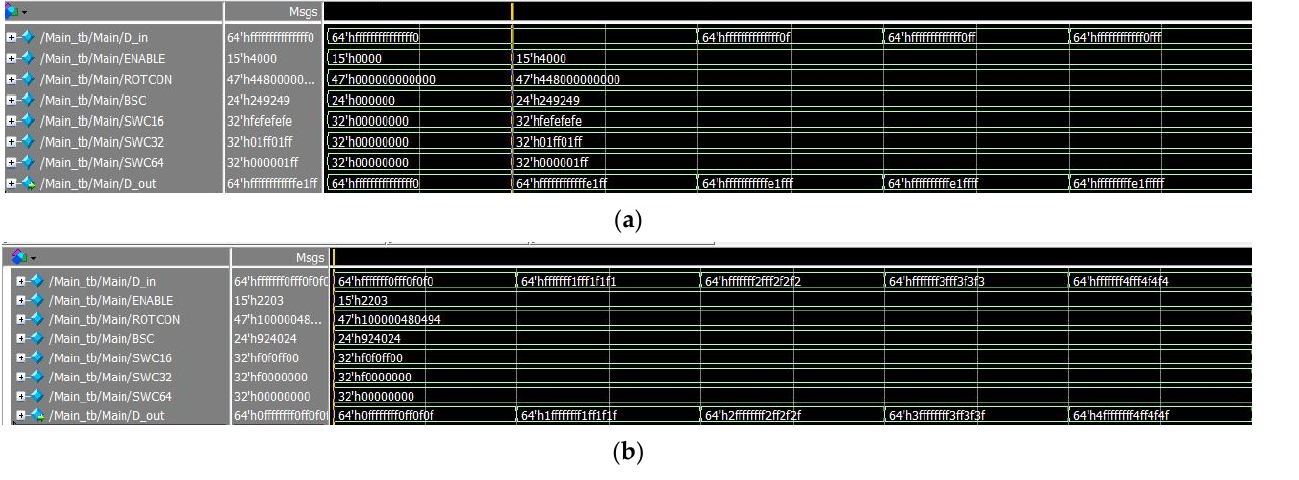
Figure 11. ( a ) The signal flow of RSTU executing a 9-bit left rotation operation for D_in. ( b ) The Signal flow of RSTU executing a 4-bit right rotation for the upper 32-bit of D_in, an 8-bit left rotation for D_in [31:16], and two 4-bit left rotation for the lower octet and next lower octet of D_in. For the second group excitation vectors, ENABLE and ROTCON have stated that RSTU implements a 4-bit right rotation for the upper 32-bit of D_in, an 8-bit left rotation of D_in [31:16], and two 4-bit left rotation of the lower octet and next lower octet of D_in. The generated BSC and SWC are shown in Figure 11b. The eight-barrel shifters shift to the left by four, four, four, four, zero, zero, four, and four bits, respectively. Four SW16 respectively execute the functions of upper 4-bit interchanging, upper 4-bit interchanging, 8-bit interchanging, and pass-through. One SW32 interchanges the upper 4-bit of the 16-bit intermediate results. The other SW32 and SW64 gets past the input. The final result shows that the D_out = {D_in [63:32] <<< 4||D_in [31:16] <<< 8||D_in [15:8] <<< 4||D_in [7:0] <<< 4} function execution is correct.